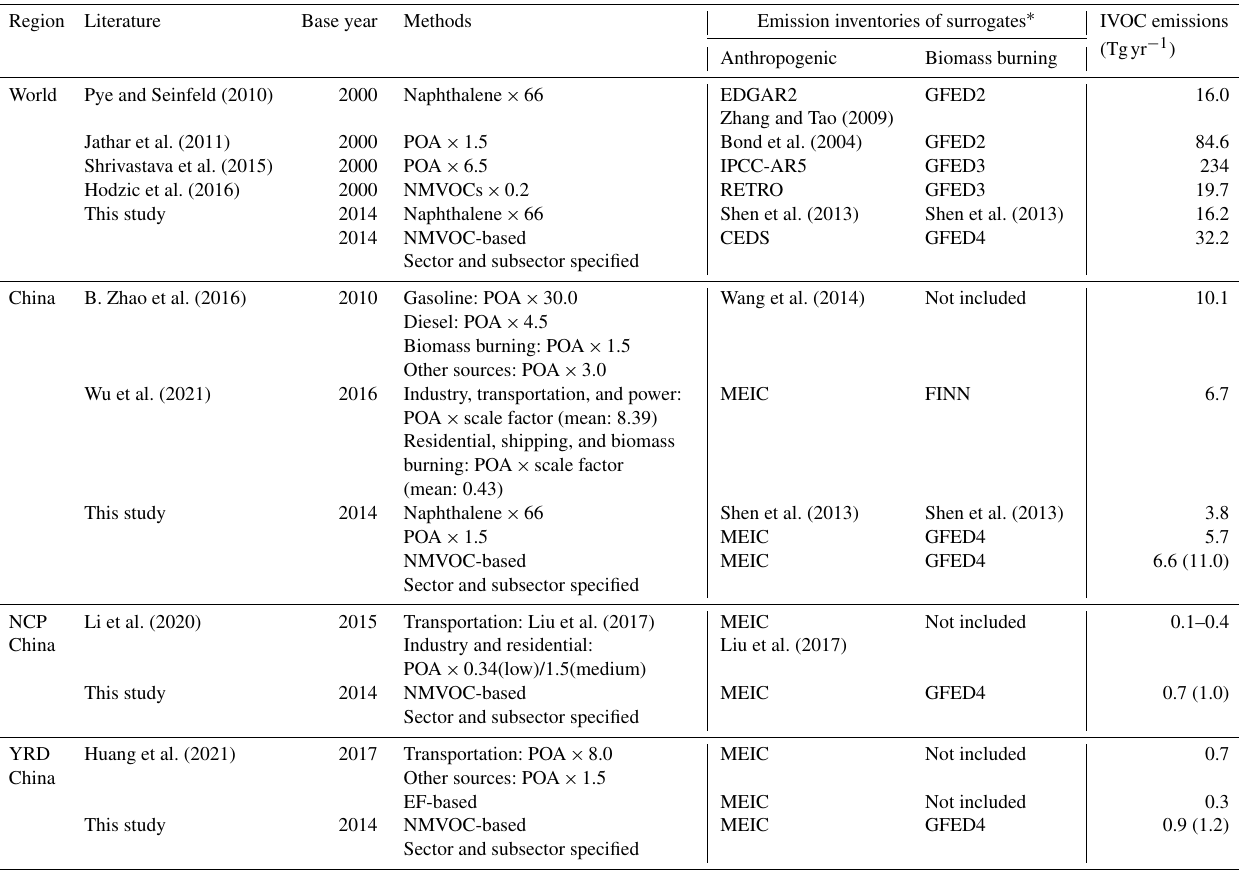
Table 2. The annual emissions of IVOCs derived by different approaches in the literature and in our study. The values in parentheses are the IVOC emissions when the residential emission is multiplied by a factor of 7.